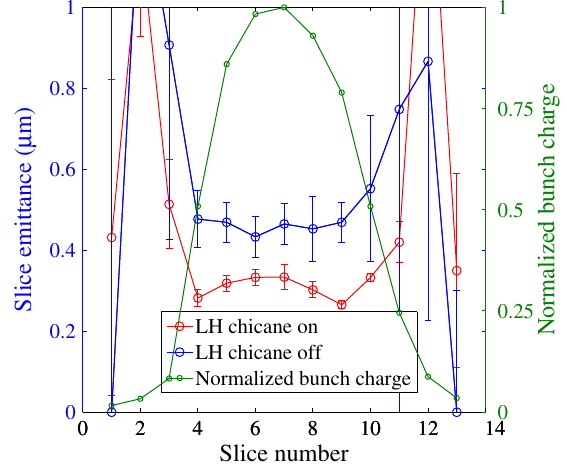
FIG. 4. Horizontal slice emittance, comparing the cases LH chicane on and off, as measured in the LCLS injector at 135 MeV, for Q ¼ 150 pC. The bunch shape is given in green. Note that emittance values measured in the beam tails are inaccurate and should be ignored.